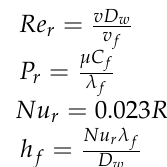
( d ) Figure 12. Heat dissipation contour of cooling system: ( a ) CHTC distribution; ( b ) Velocity stream- line distribution; ( c ) Pressure distribution; ( d ) Temperature distribution of the stator.